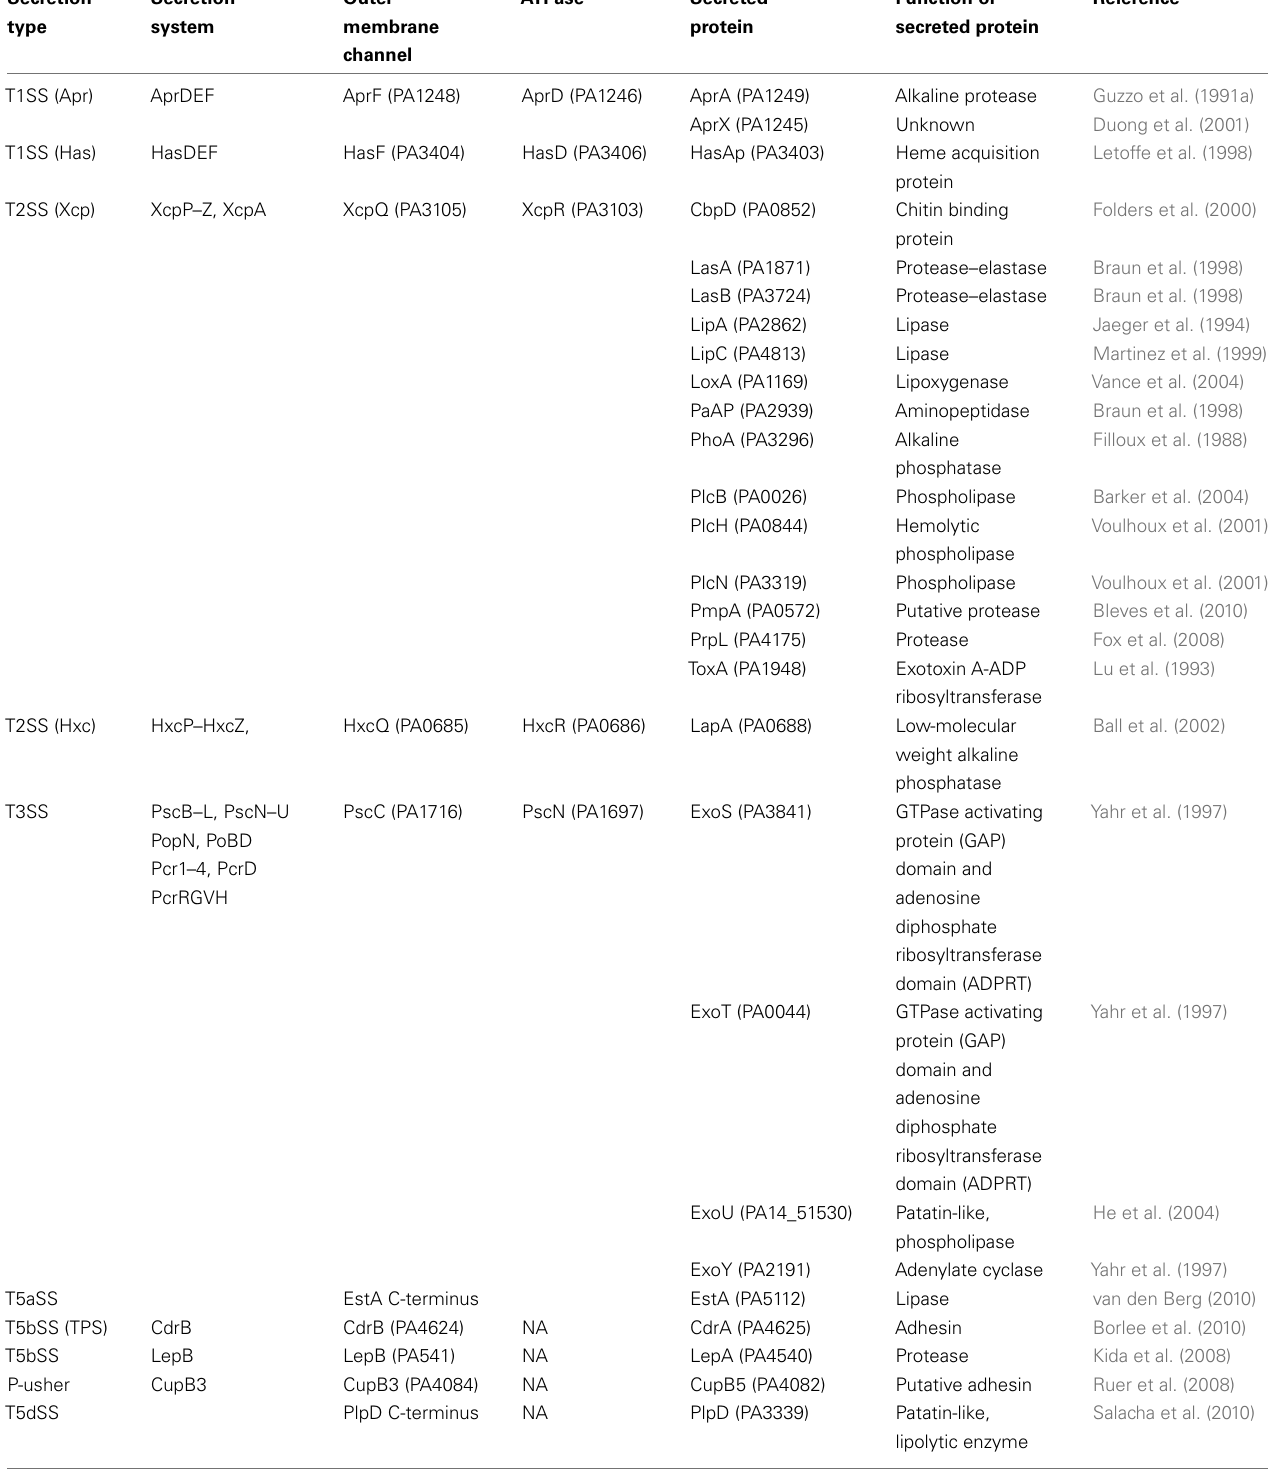
Table 1 | Characterized secretion systems and secreted proteins in P. aeruginosa